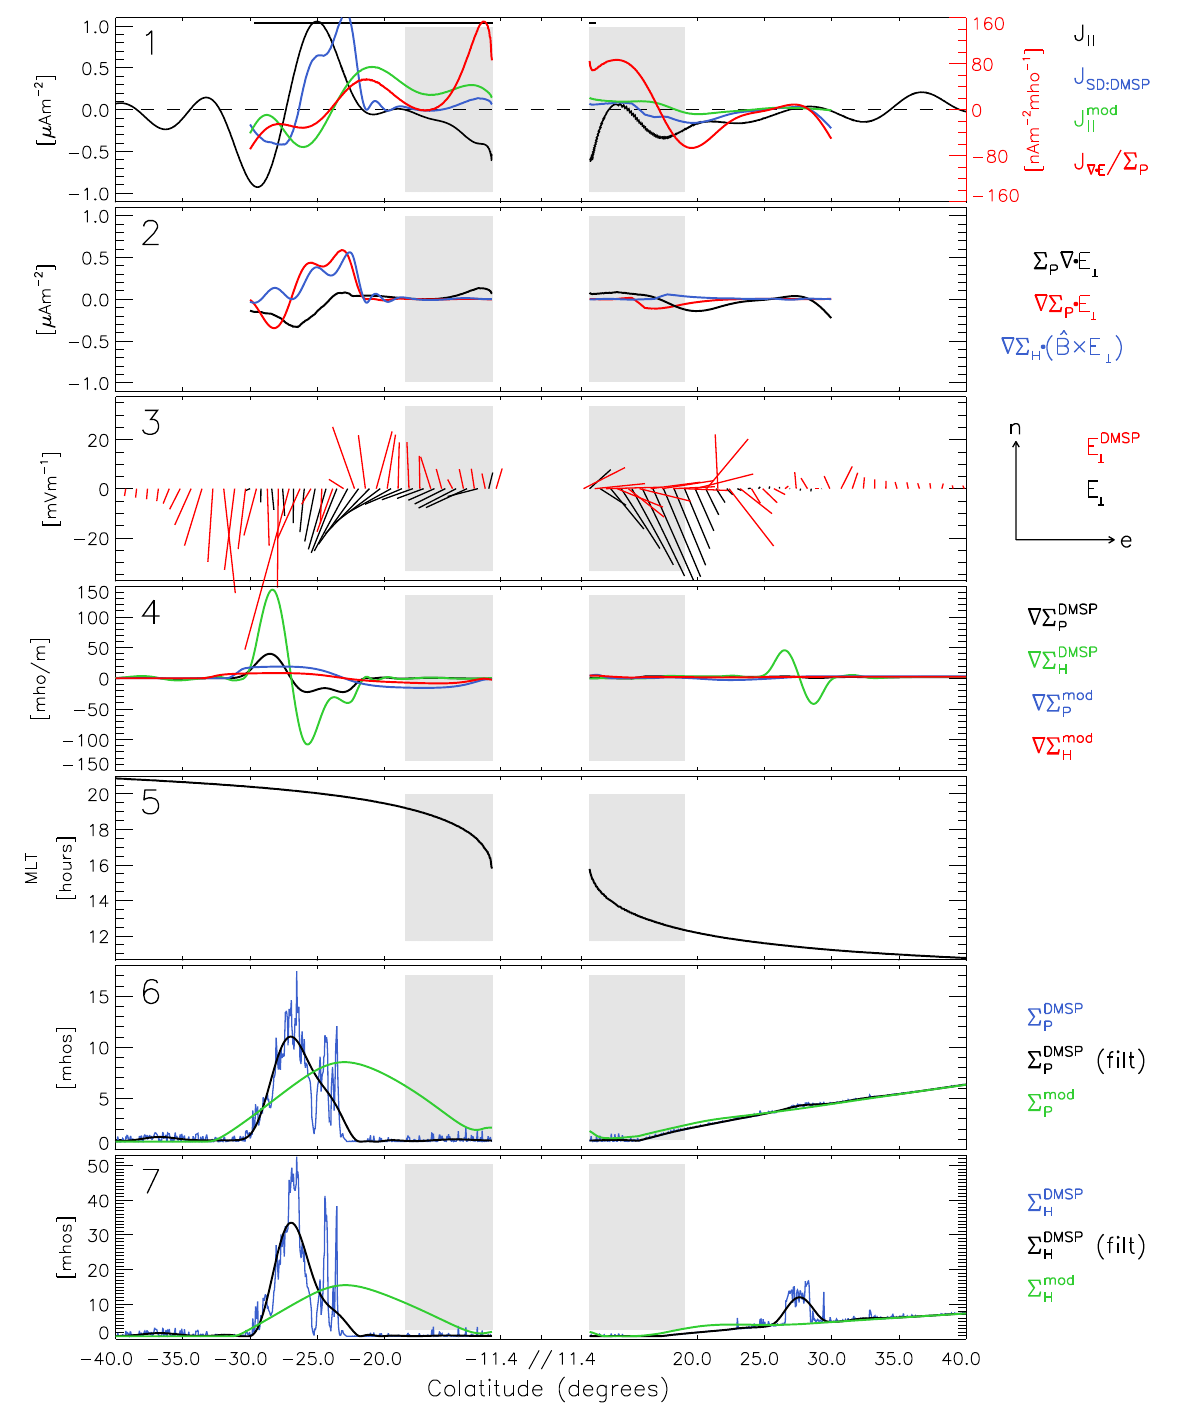
Fig. 17. Iridium, DMSP F15, and radar data for 1 November, 2001. Panel 1: Birkeland currents estimated from various sources (see text), Panel 2: Birkeland current terms from Eq. (3) using DMSP F15 derived conductance, Panel 3: Electric field from the radars and DMSP drift meter data, panel 4: DMSP F15 and model derived conductance gradients, Panel 5: DMSP satellite MLT coordinate, panel 6: Pedersen conductance derived from the DMSP F15 data and the conductance model, panel 7: Hall conductance derived from the DMSP F15 data and the conductance